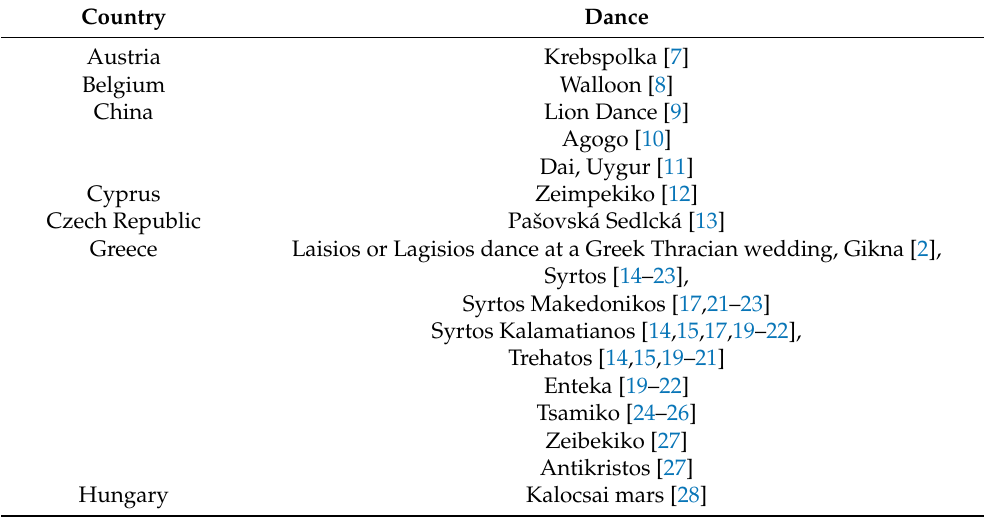
Table 1. Traditional dances in the selected